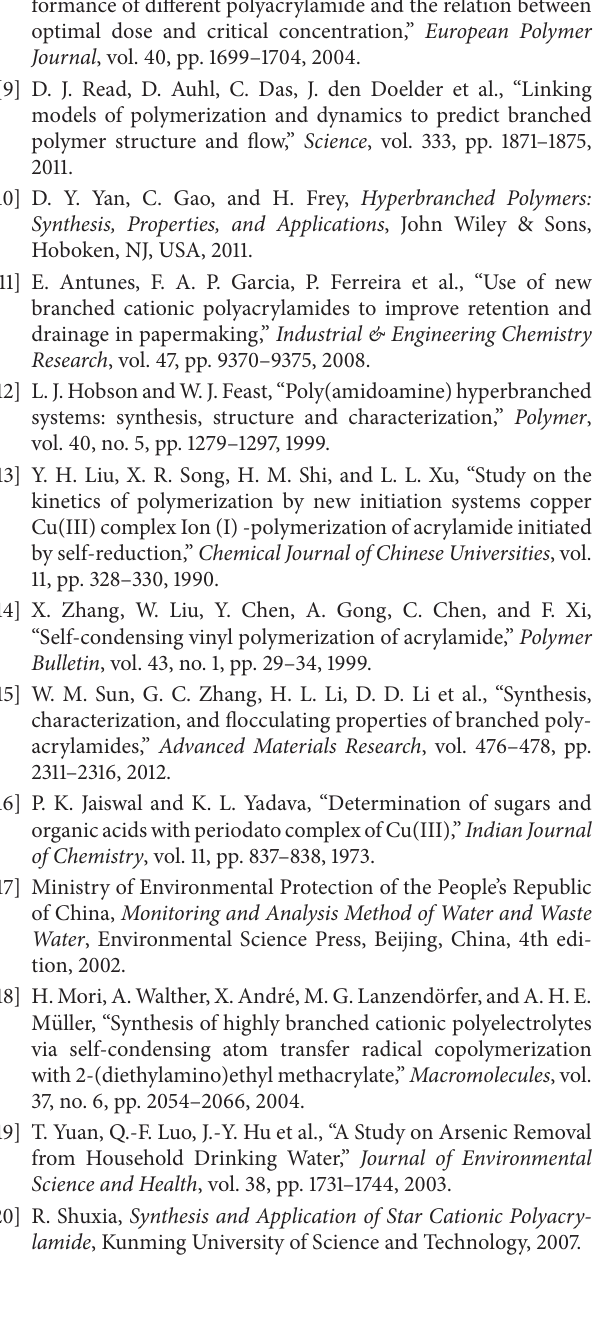
Table 7: Optimization of factors and